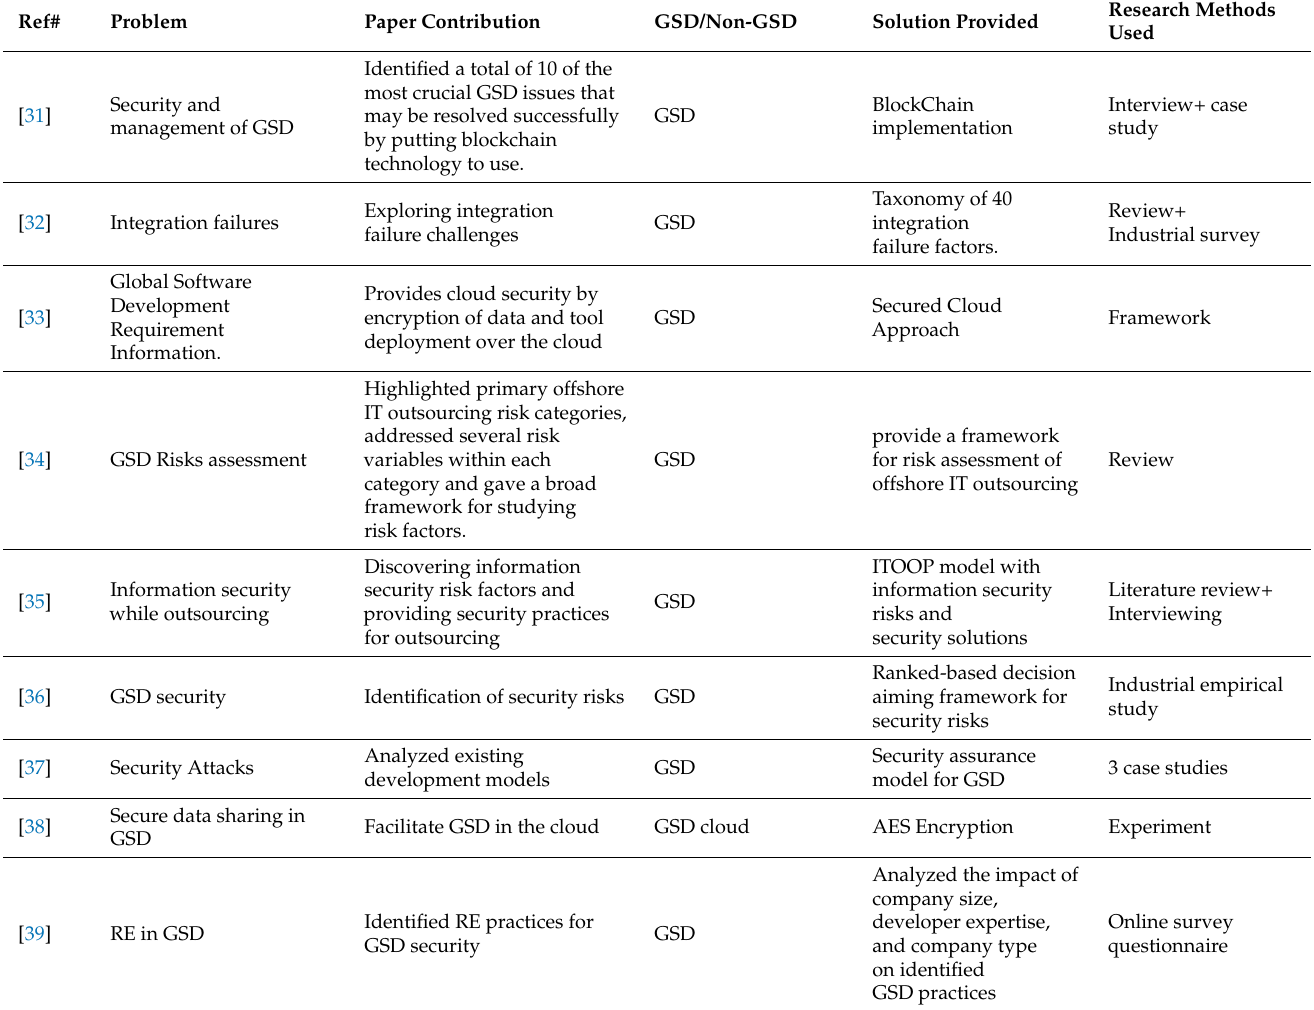
Table 2. Comparison of existing